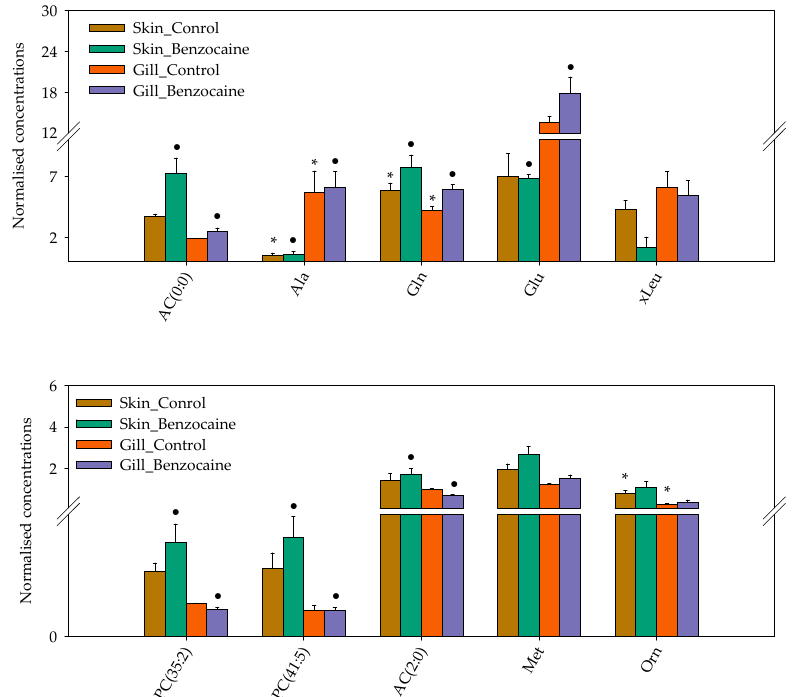
Figure 4. Top 10 most differential metabolites that contributed to differences between gill and skin mucus from salmon euthanized using benzocaine or percussive stunning (“Control”). The metabolite levels ( µ M) detected with the AbsoluteIDQ ® p400 HR kit were normalised by median. The data are presented as the mean, error bars are the standard error. Metabolites that were found in significantly different (FDR-adjusted p ≤ 0.1) concentrations with a fold-change ≥ 2: (*) in skin mucus as compared to the gill mucus and (•) in skin mucus followed by benzocaine treatment. AC (0:0), carnitine; AC (2:0), acetylcarnitine; Ala, alanine; Gln, glutamine; xLeu, sum leucine + isoleucine; Met, methionine; Orn, ornithine. Although a PCA score plot revealed a clear separation between gill and skin mucus samples, it did not show obvious variation in the data associated with benzocaine treat- ments (Figure 5).